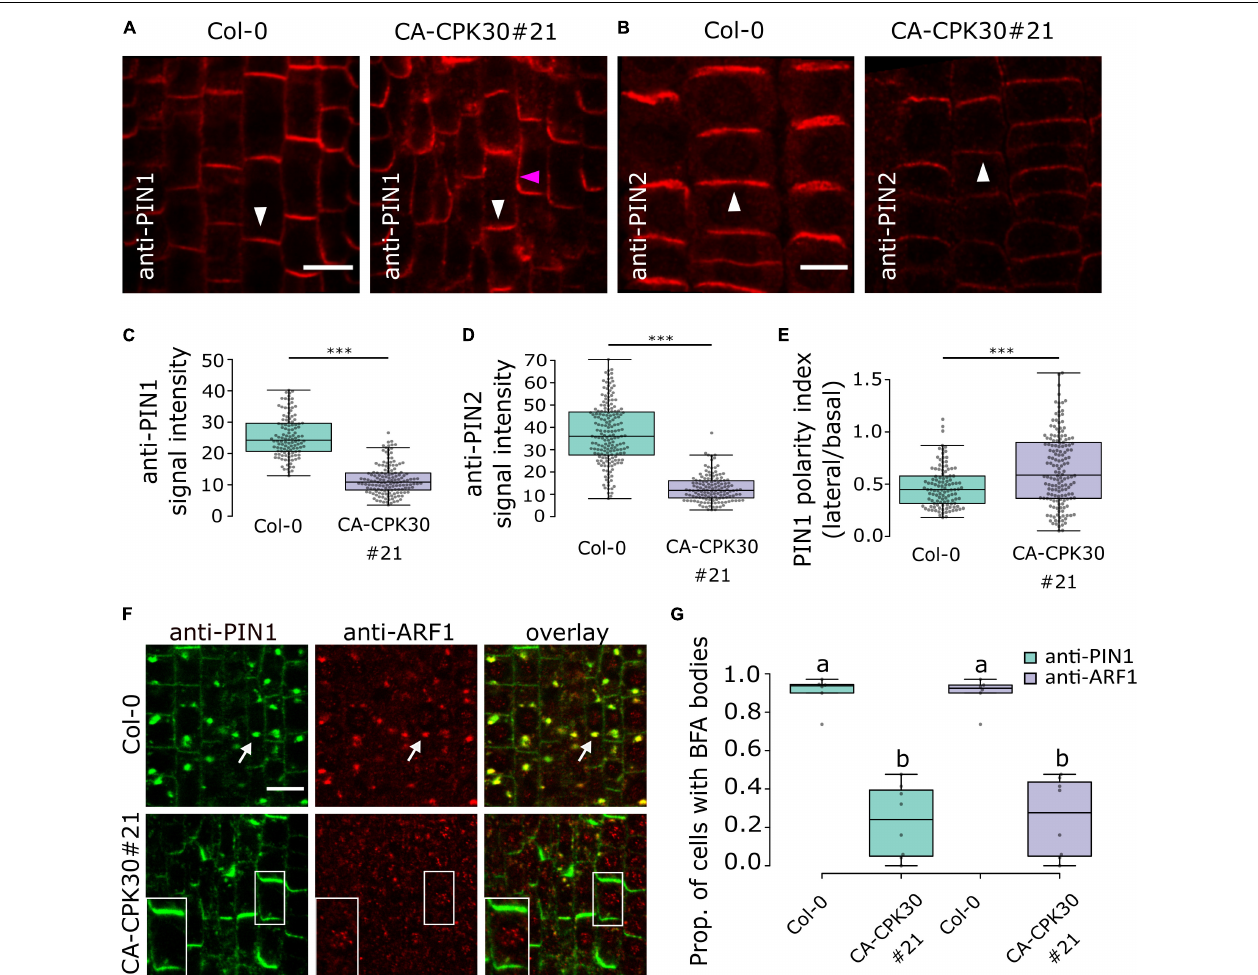
FIGURE 3 | Induction of CA-CPK30 causes endomembrane trafficking defects. (A,B) Immunolocalization of PIN1 (A) and PIN2 (B) in roots of β -estradiol-treated Col-0 and CA-CPK30#21. White arrowheads indicate the expected polar domain of the respective PINs. The pink arrowhead indicates ectopic, lateral PIN1 signal. Scale bar = 20 µ m. (C) Quantification of anti-PIN1 signal intensity in the plasma membrane of stele cells for Col-0 and CA-CPK30#21. For Col-0 n = 119 cells from 11 roots, for CA-CPK30#21 n = 147 cells from 9 roots pooled from two replicates. (D) Quantification of anti-PIN2 intensity in the plasma membrane of epidermal cells for Col-0 and CA-CPK30#21. For Col-0 n = 183 cells from 12 roots, for CA-CPK30#21 n = 140 cells from 11 roots pooled from two replicates. (E) Quantification of PIN1 polarity, based on the ratio of the PIN1 signal in the lateral/basal side for individual cells in Col-0 and CA-CPK30#21. For Col-0: n = 113 cells from 11 roots, for CA-CPK30#21: n = 158 cells from 10 roots, two replicates. (Unpaired Student’s t -test; *** P ≤ 0.001 for C–E ). (F) Whole-mount immunolocalization using anti-PIN1 and anti-ARF1 antibodies in 5 day-old seedling root meristems of BFA-treated Col-0 and CA-CPK30#21 seedlings. Seedlings were transferred for 1 day to 2.5 µ M β -estradiol prior to 1 h BFA (25 µ M) treatment. White arrows indicate PIN1, ARF1 co-localization in BFA bodies. Insets are magnifications of a single cell of the BFA-treated CA-CPK30#21. Scale bar = 10 µ m. (G) Boxplot representation of the proportion of cells with BFA bodies for treatments to Col-0 and CA-CPK30#21 (for Col-0: n = 6 and for CA-CPK30#21: n = 8 in total from two replicates). Significant differences ( P ≤ 0.05, Wald-type test) are indicated by different lowercase letters. For all box plots, the central line indicates the median, the bottom and top edges of the box the interquartile range, and the box plot whiskers are plotted down to the minimum and up to the maximum